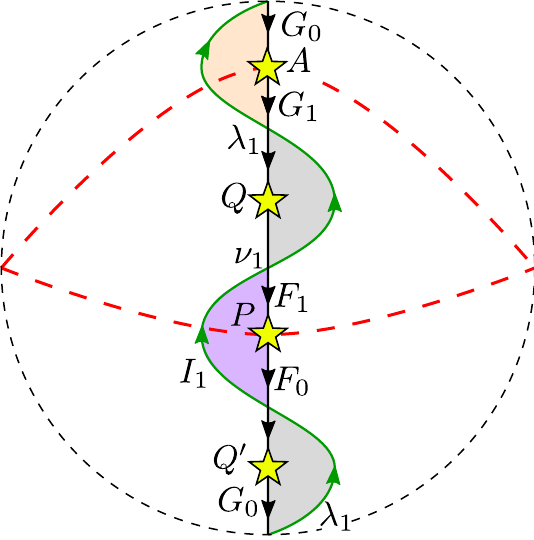
Figure 5 . Structure of branes and the orientifold involution on (cid:6). We outer dashed line should be identi(cid:12)ed with a point to obtain P 1 . The four punctures have been marked by stars, and the orientifold involution induces a re(cid:13)ection along the red line (which becomes a re(cid:13)ection along the equator on P 1